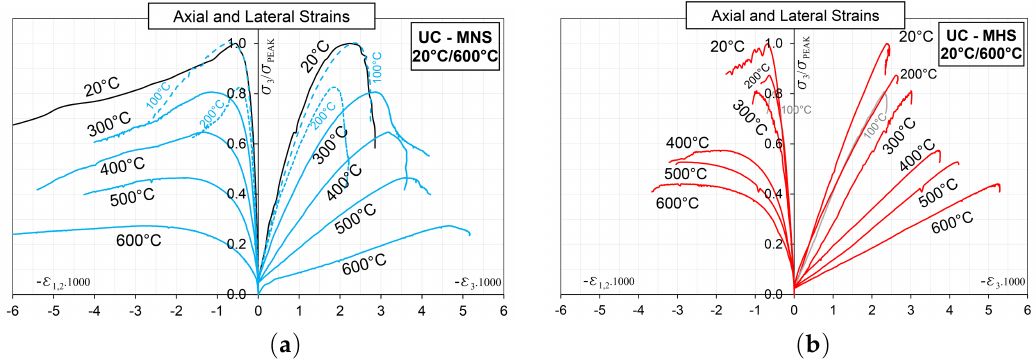
Figure 12. Uniaxial Compression—Mean axial stress vs. axial and lateral strains curves, normalized in terms of the peak stress at 20 ◦ C for all the considered temperatures and for: ( a ) MNS and ( b )